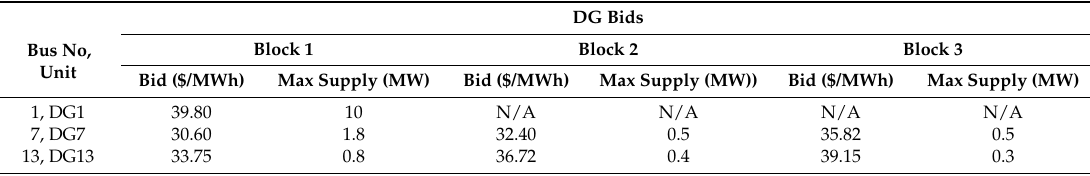
Table 3. LA bid price and maximum demand ( δ D